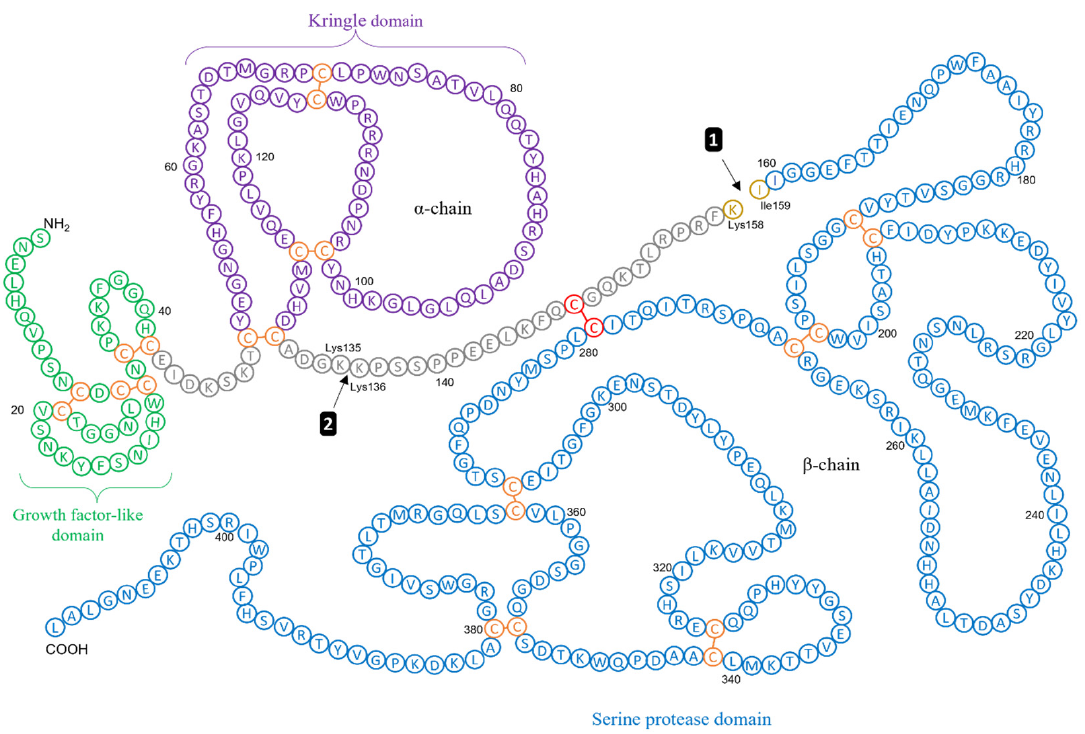
Figure 2. Schematic Illustrating the Structural Domains of Pro-uPA and uPA. Single chain zymogen, pro-uPA, consists of three domains: a growth-factor domain, a kringle domain and a serine protease domain. Arrow 1 shows the first cleavage between Lys158 and Ile159 to produce the two-chain catalytically active uPA (residues 1–411), also known as high molecular weight (HMW) uPA, which is linked by a single disulphide bond. Arrow 2 shows the second cleavage between Lys135 and Ile136 to yield low-molecular weight (LMW) uPA (residues 136–411) and an inactive amino-terminal fragment (ATF; residues 1–135). Adapted from Shetty and Idell [62].